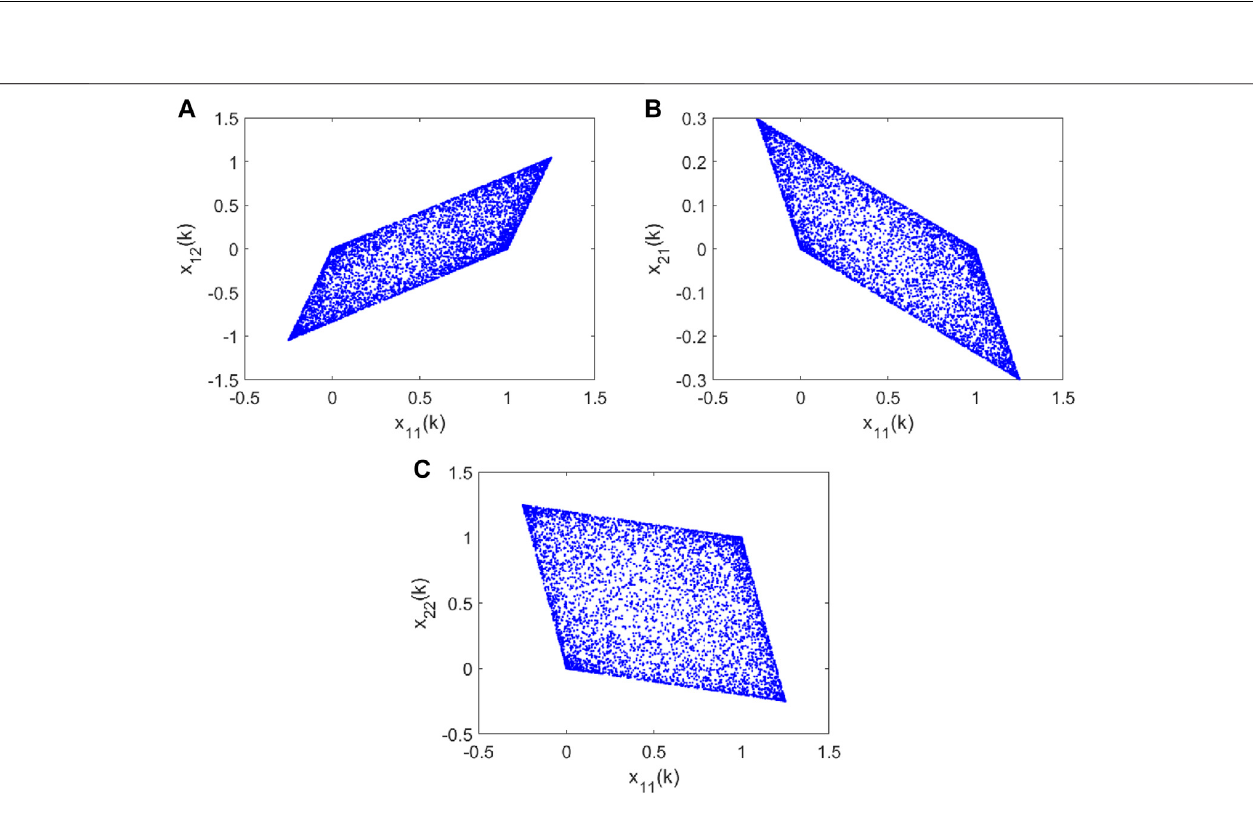
Frontiers in Physics |